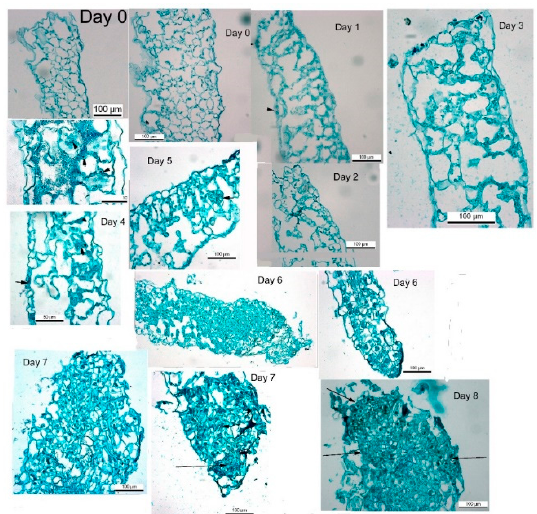
Figure 2. Cross sections of leaf segments taken during the first 8 days on REG medium. Arrowhead in Day 1 indicates stomata and arrows in Days 4, 5, 7, and 8 indicate cell clusters with cell divisions which will may form shoots.